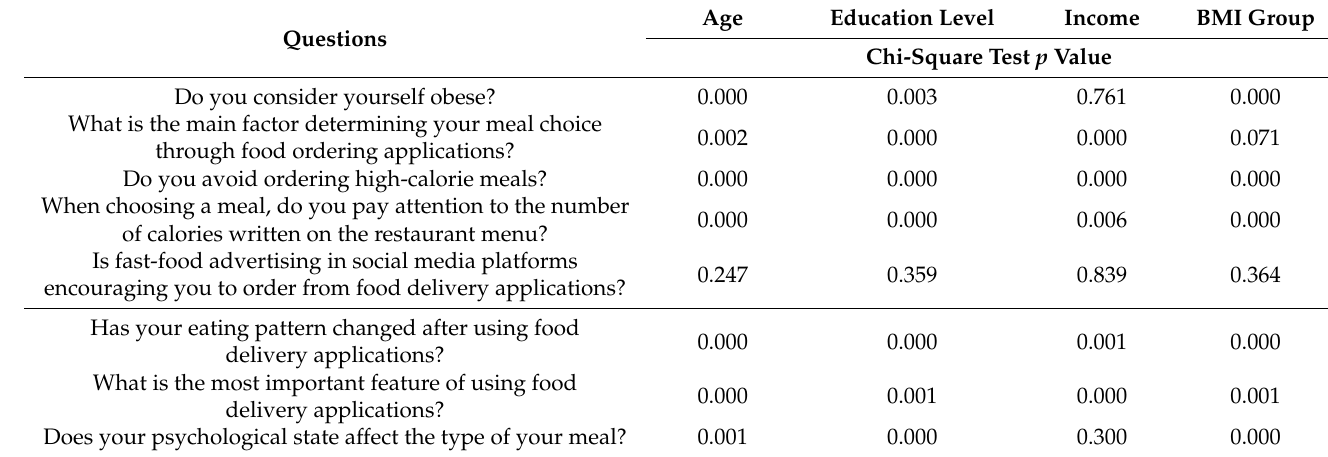
Table 3. Exploring the relationship between sociodemographic characteristics (age, education level, income and BMI group) with selected questions on using food delivery applications (FDAs) and participant’s dietary behaviour and preferences using Chi-Square test’s p -value.